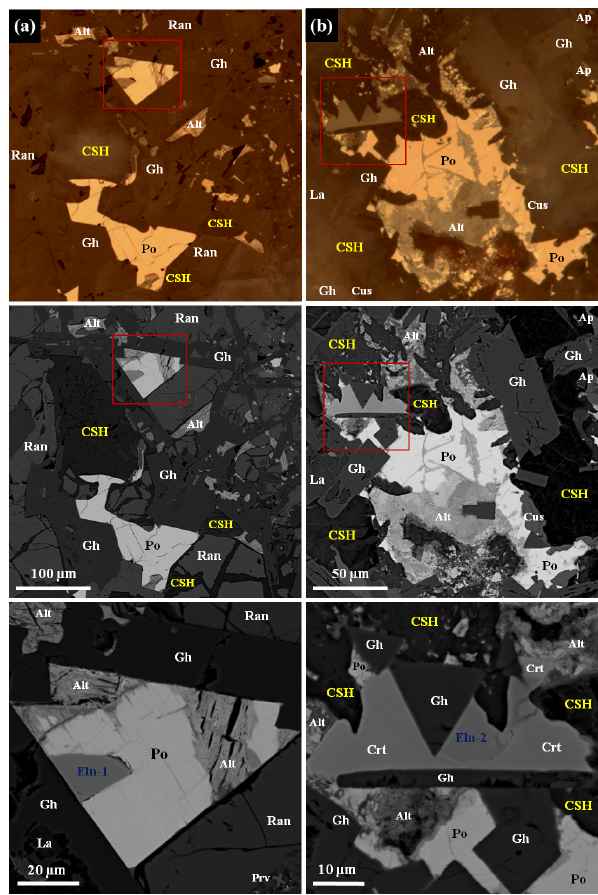
Figure 3. Areas with ellinaite in gehlenite-rankinite paralava (a–b) , Hatrurim Basin, Israel. BSE and reflected light images. Symbols: